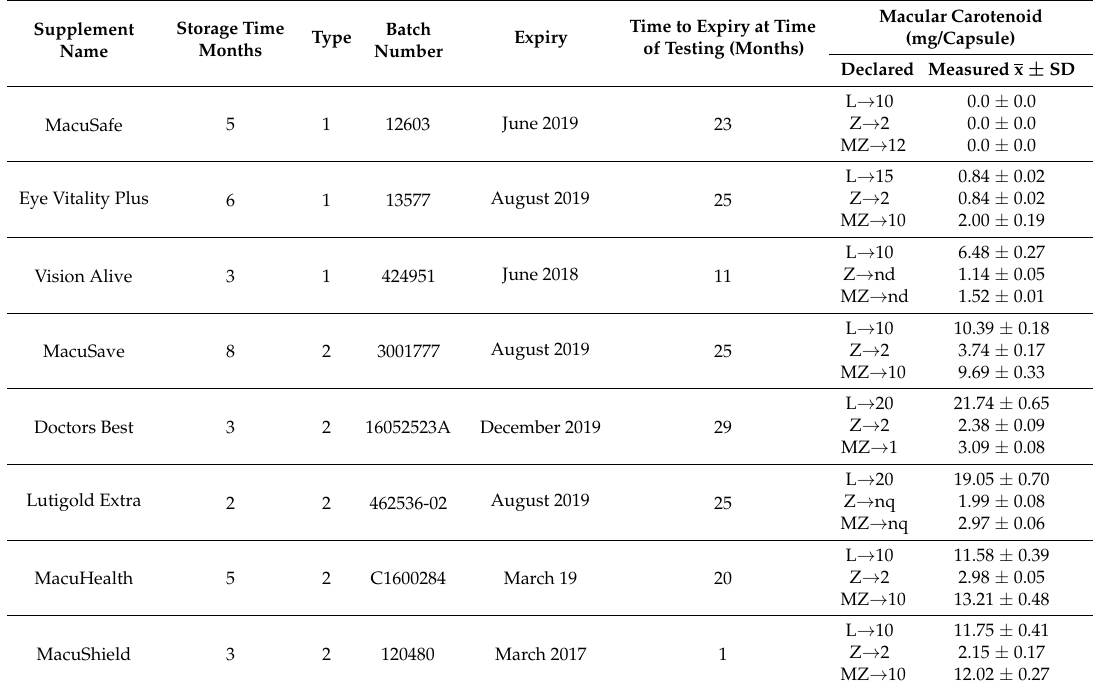
Table 2. Re-analysis of macular carotenoid concentration of the commercially available supplements analysed after storage.